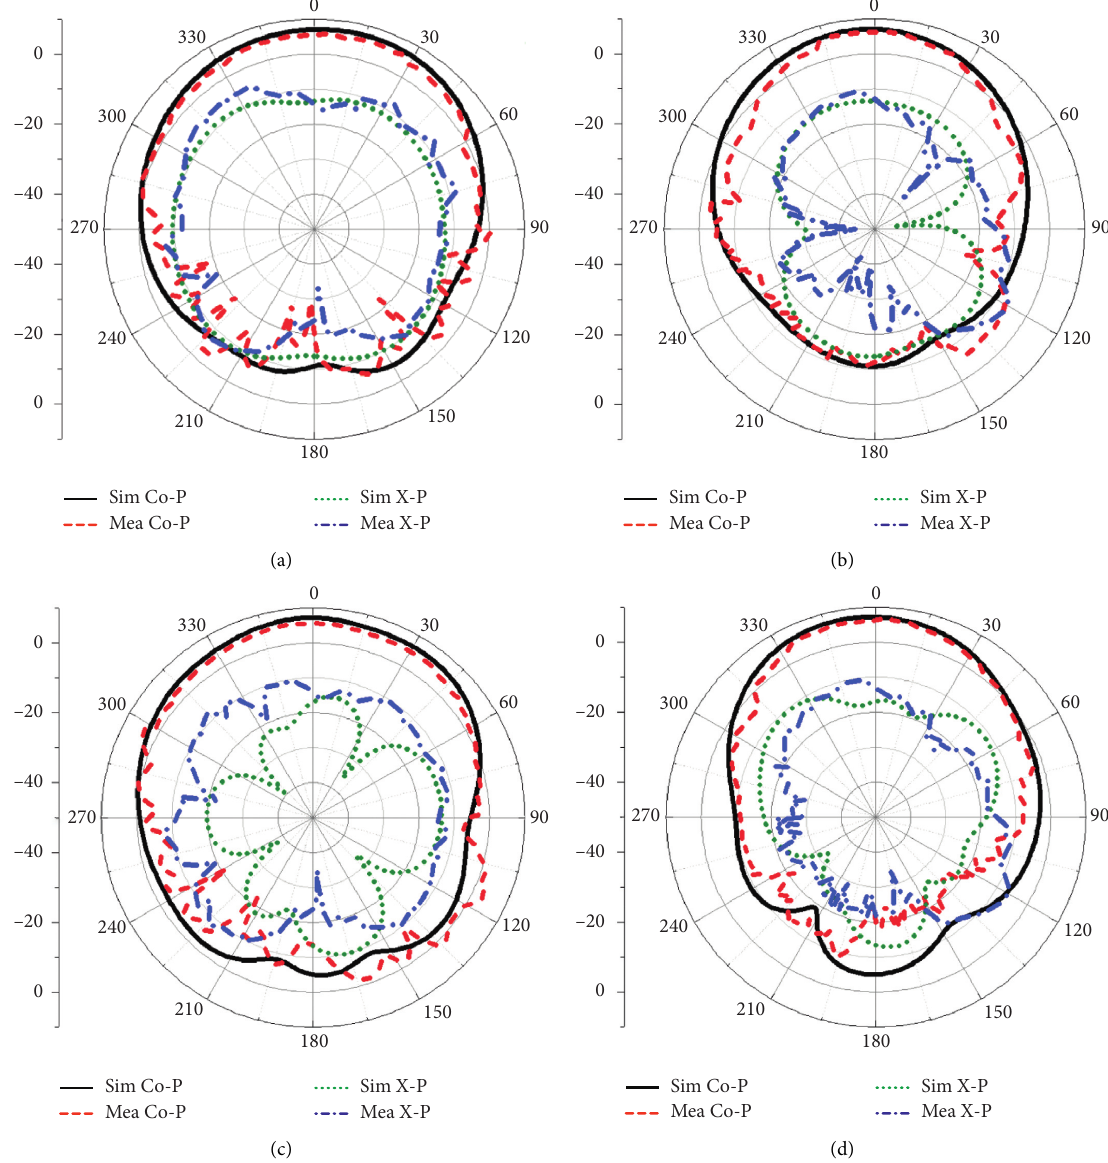
Figure 13: Simulated and measured radiation patterns of the proposed MIMO antenna with SNLs. (a) 4.46 GHz, E-plane ( xz -plane). (b) 4.46 GHz, H-plane ( yz -plane). (c) 5.38GHz, E-plane ( xz -plane). (d) 5.38 GHz, H-plane ( yz